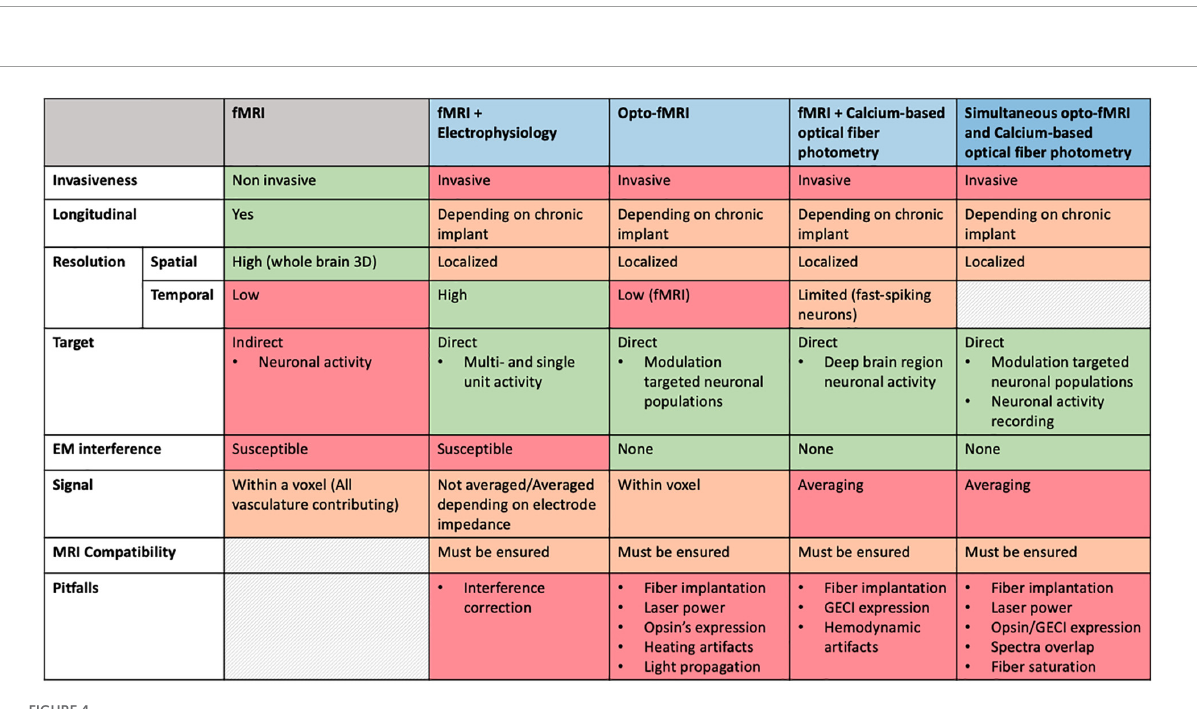
FIGURE4 Comparative overview of specifications for multimodal imaging